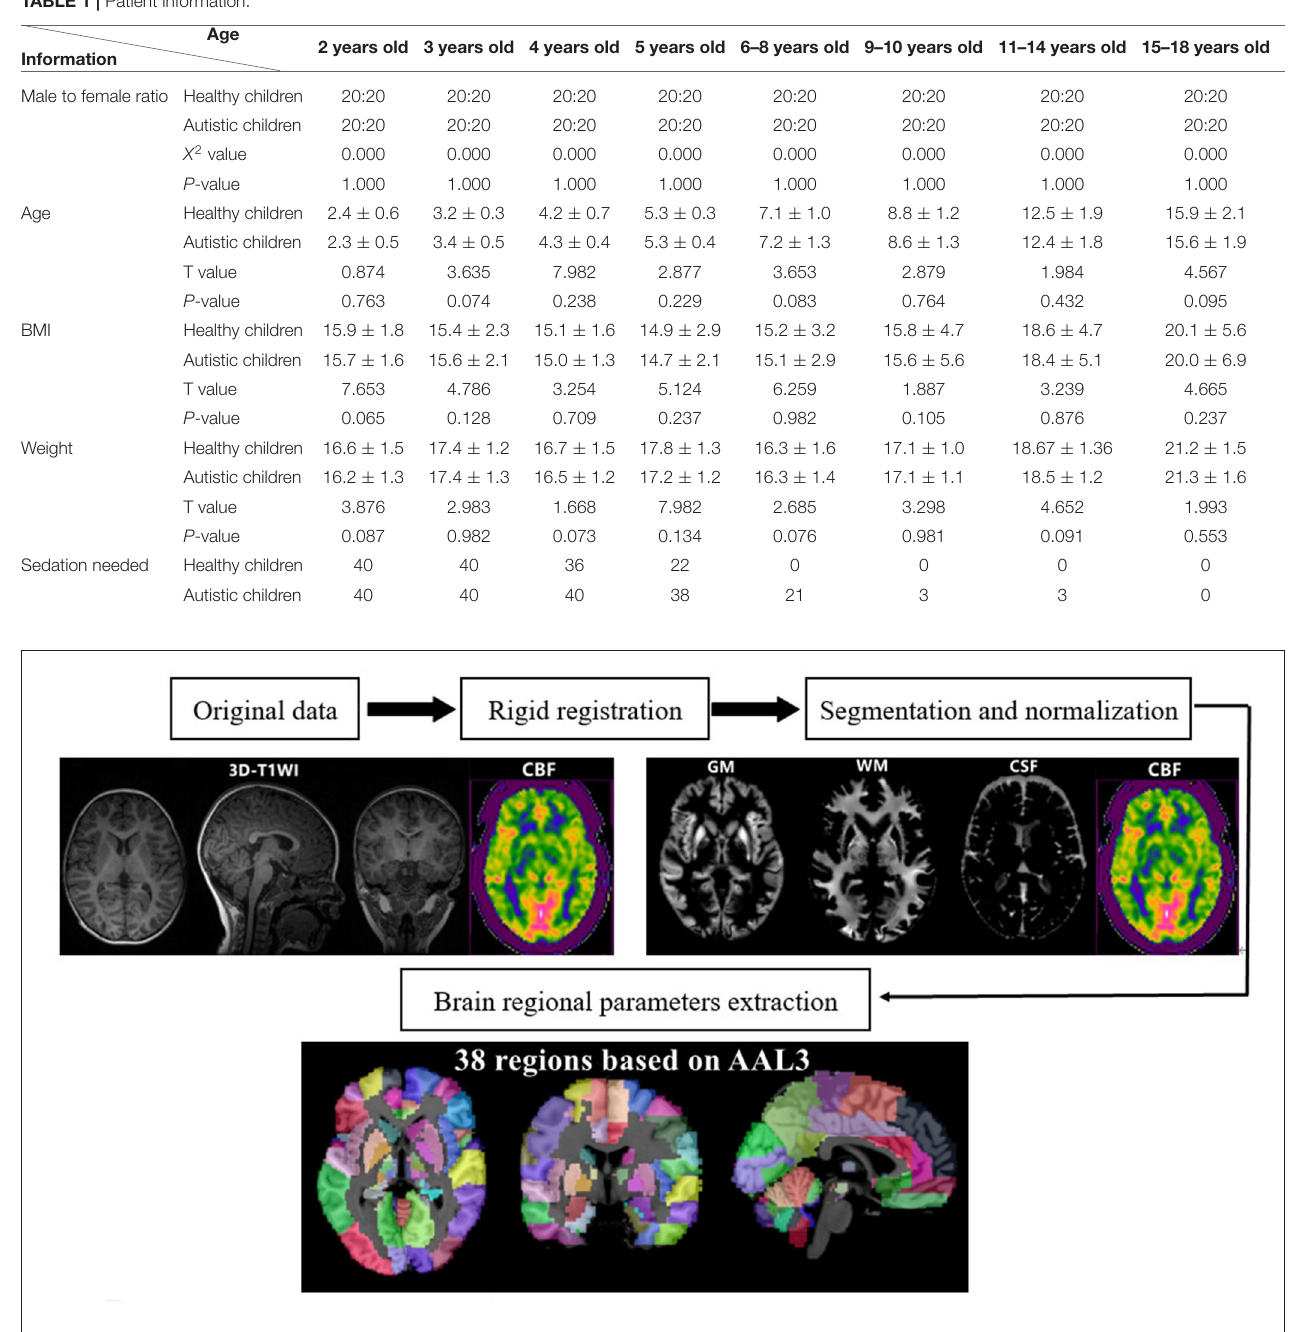
FIGURE 1 | Schematic diagram of brain volume and CBF parameter extraction.